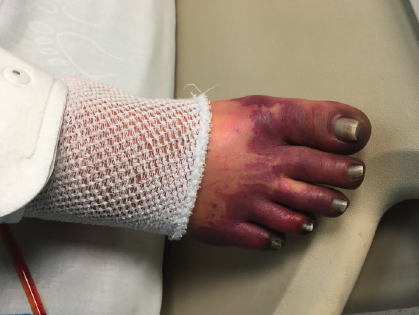
Figure 2: Purpura fulminans: haemorrhagic necrosis of the skin in the patient’s foot.